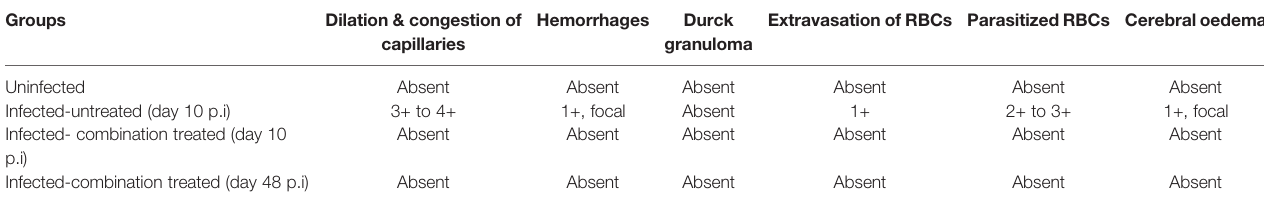
TABLE 3 | Experimental mice were randomly divided into 2 different groups (n=12) after infection with 1X10 6 P. berghei ANKA.